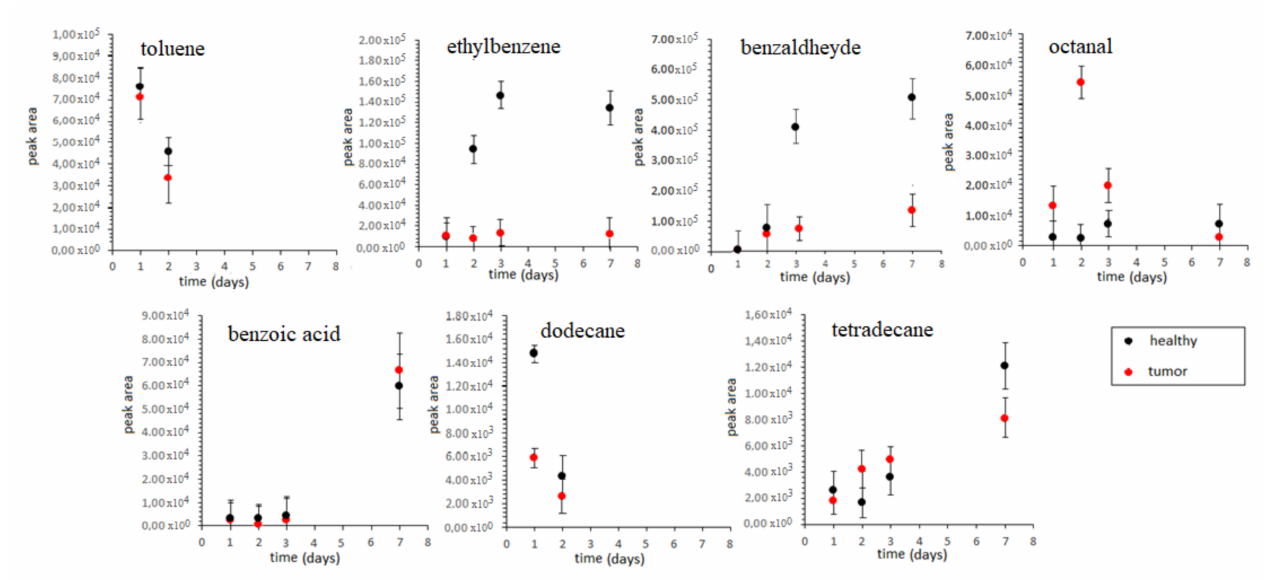
Figure 6. Kinetic profiles of seven selected analytes secreted by surgical resected colon tissues (healthy tissue and tumor) from three CRC